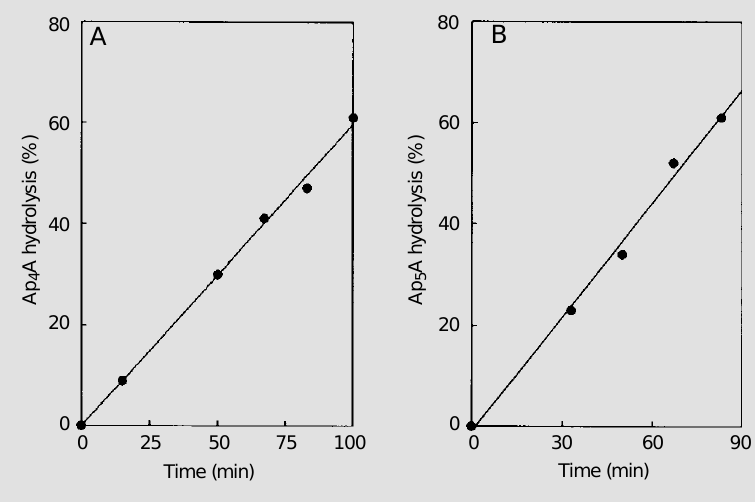
Figure 2 - Ap 4 A (A) and Ap 5 A (B) hydrolysis by synaptosomes as a function of time. The enzyme assay was carried out as described in the Legend to Figure 1, with 85 µg protein/ 200 µl at 37 o C. The data are representative of three independent experiments with different synaptosome